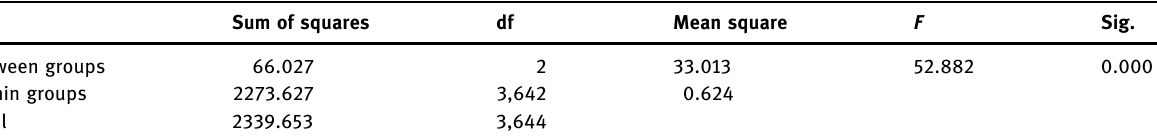
Table 20: Analysis of variance of awareness level by island Sum of squares